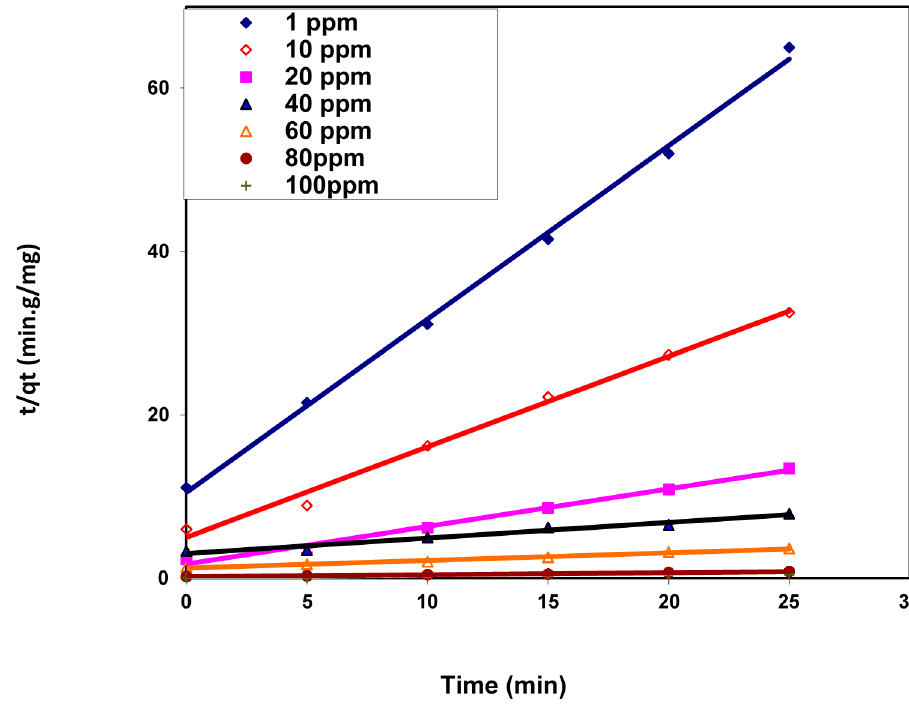
Figure 9. Pseudo-second-order kinetic model for BV 14 dye adsorption onto the chemically modified nanofibers.